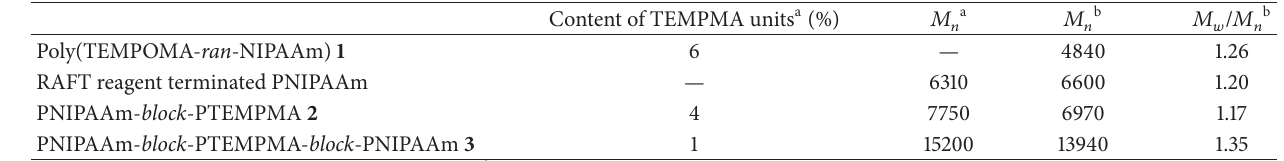
Table 1: Molecular weight data of the resulting copolymers.